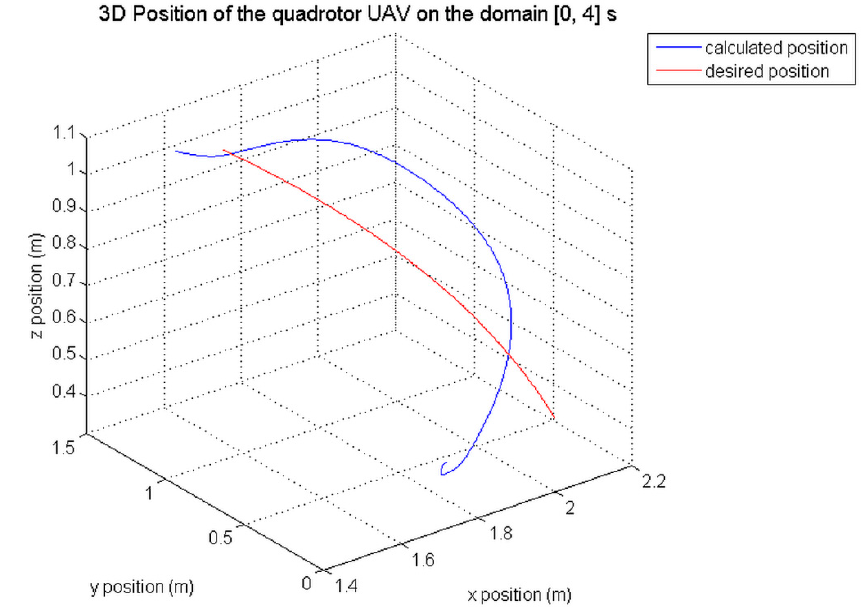
Figure 26. The 3D position of the quadrotor UAV obtained by the CMTC in the time interval [0, 4] s.